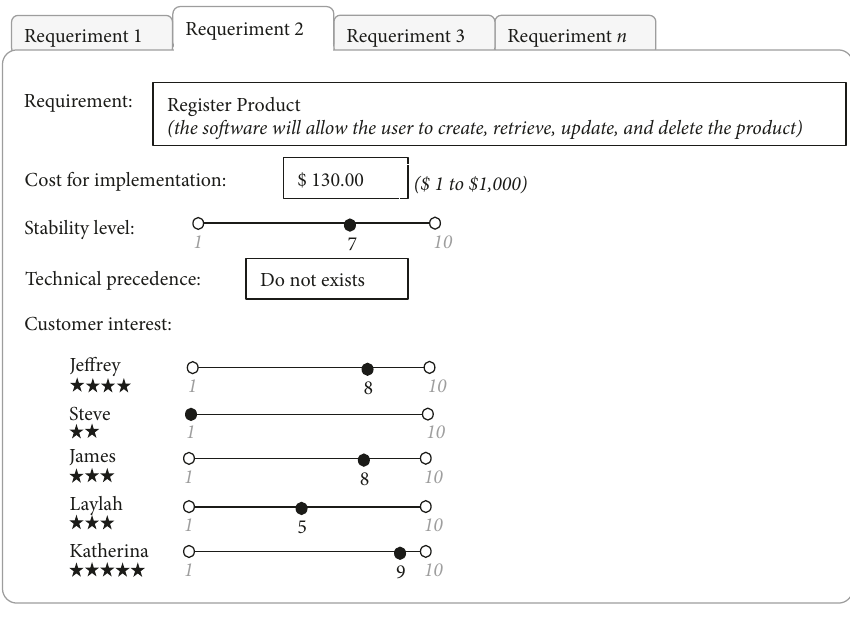
Figure 7: Illustration of requirement